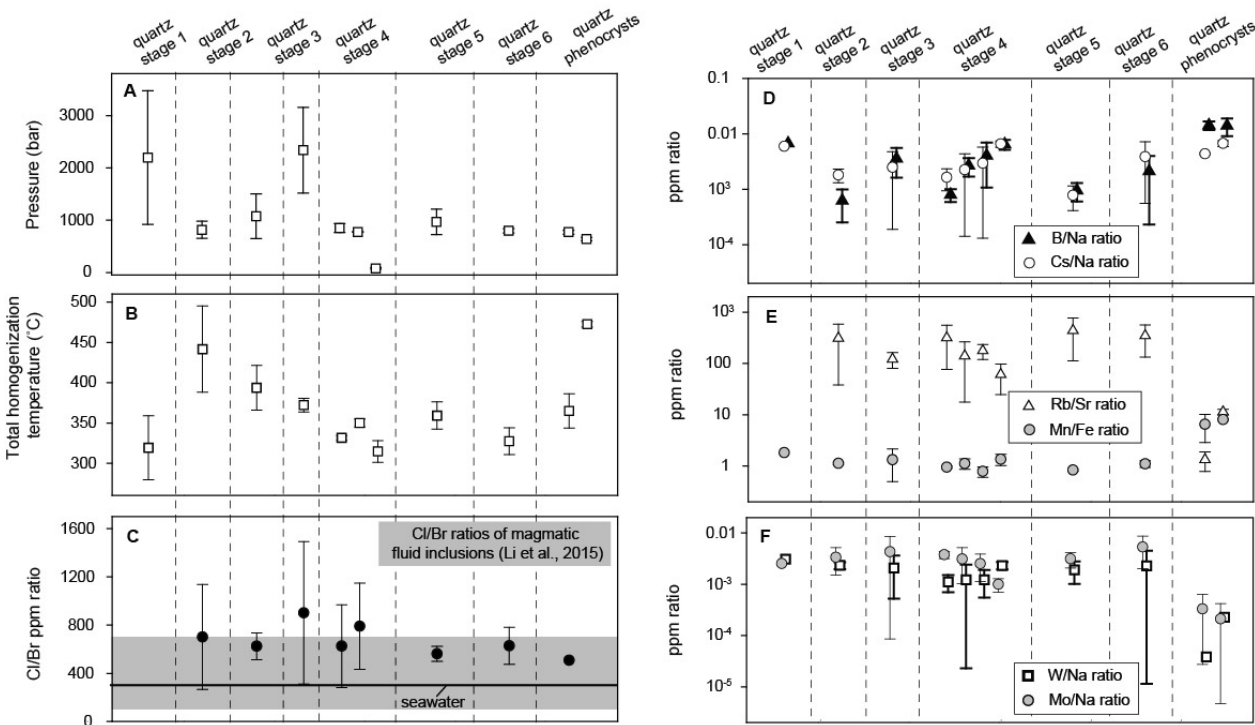
Figure 7. Sequences of microthermometric P-T information and trace element ratios (obtained by LA-IC-MS microanalysis) of brine inclusion assemblages in early UST quartz stages (1–6) and postdating quartz phenocrysts. ( A ) Calculated pressures and ( B ) temperatures of total homogenizations in the brine assemblages. Trace element ratios of ( C ) Cl/Br, ( D ) B/Na and Cs/Na, ( E ) Rb/Sr and Mn/Fe, and ( F ) W/Na and Mo/Na in the same brine inclusion assemblages.